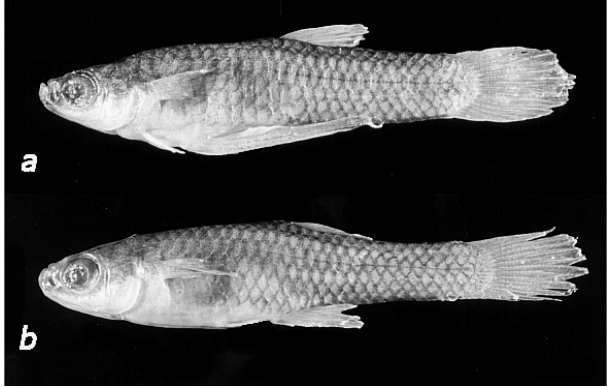
Fig. 8. Cnesterodon septentrionalis . MZUSP 69685, córrego do Mosquito, upper rio Araguaia, Mato Grosso: (a) male, 16.8 mm SL; (b) female, 19.3 mm